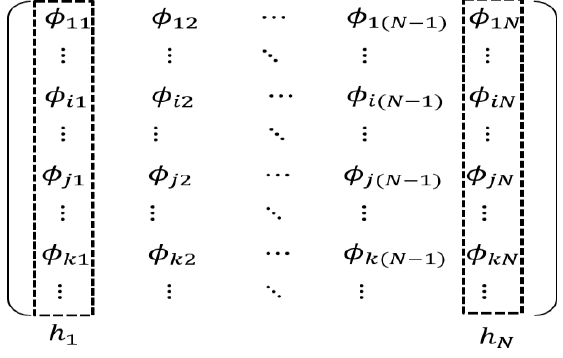
Figure 1. Formulation of the power transfer distribution factor (PTDF) matrix.